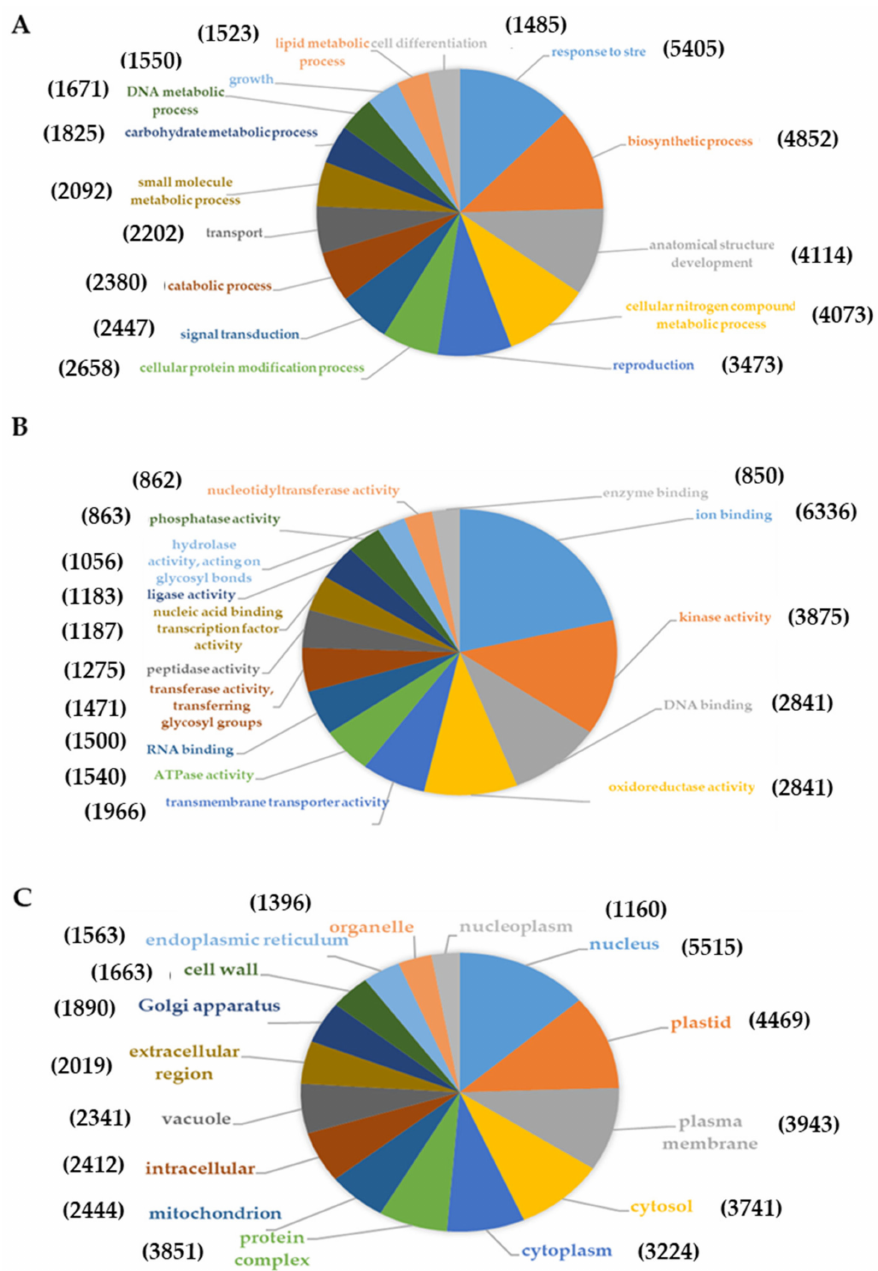
Figure 4. Pie charts of GO classification of assembled Q. ilex transcripts including the first 15 transcripts assigned to biological processes ( A ), molecular functions ( B ) and cellular compo- nents ( C ). The number in parentheses indicates the number of transcripts. The remaining transcripts assigned to each GO category are shown in Guerrero-S á nchez et al.